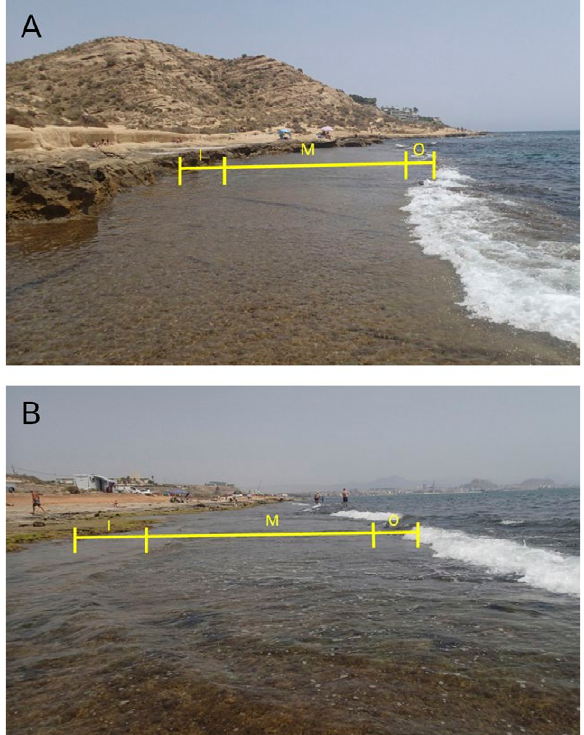
Fig. 2. – Zones surveyed at the non-degraded location (A) and the degraded location (B). Inner zone (I), mid-platform zone (M), outer platform zone